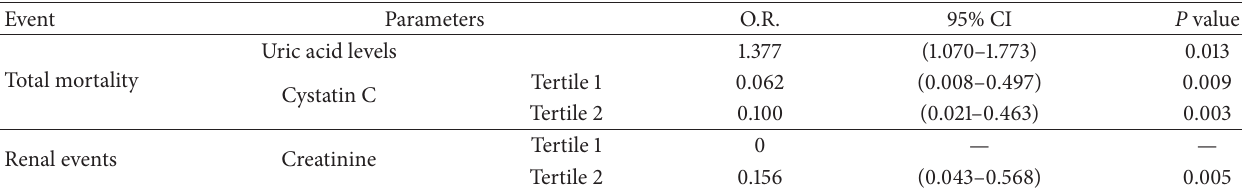
Table 3: Estimation of total mortality and renal event risk.